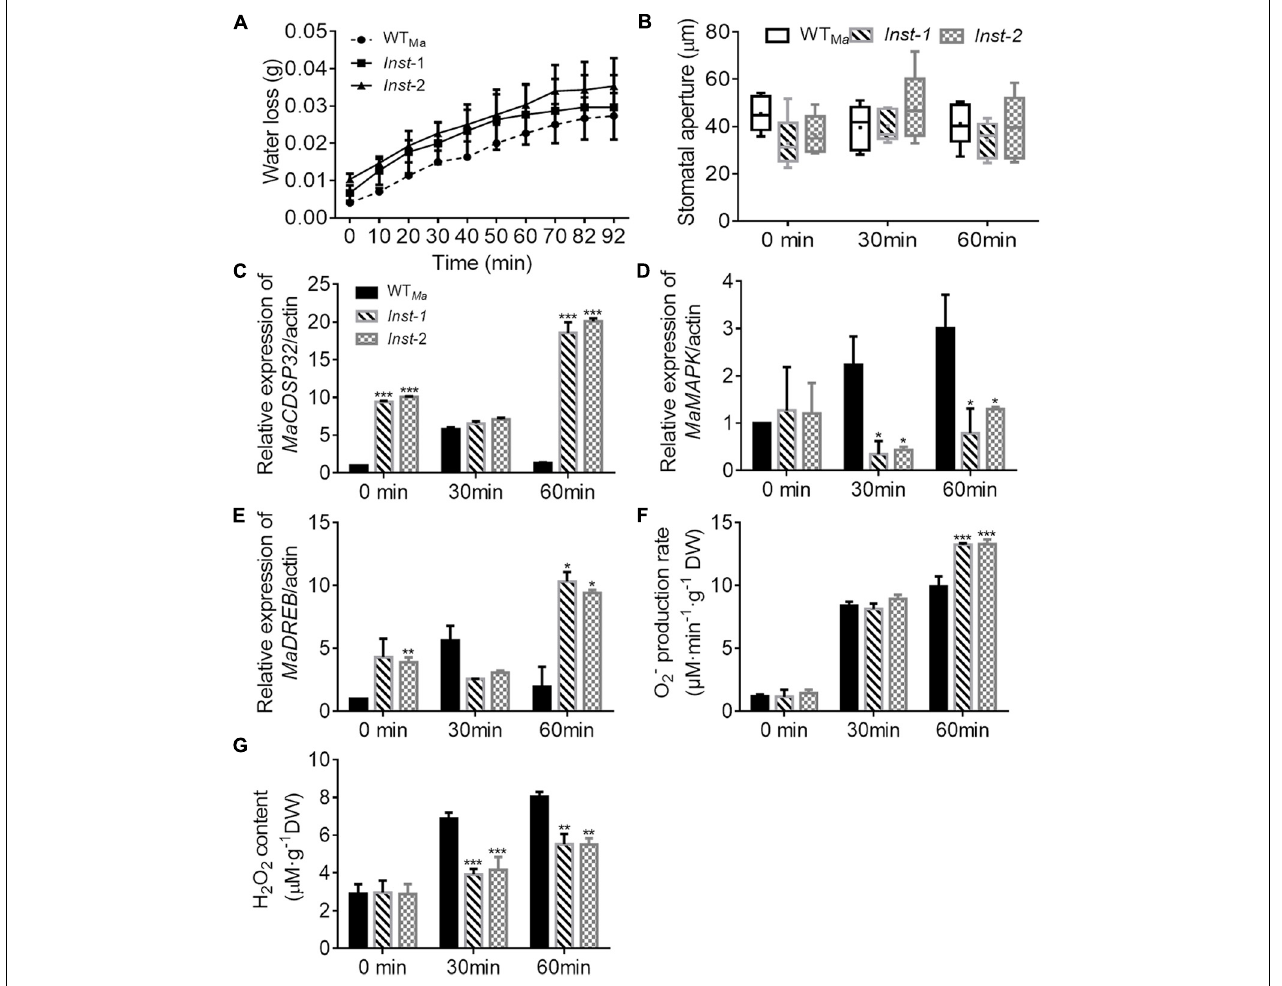
FIGURE 3 | The transient overexpression of MaCDSP32 increases leaf water loss under desiccation conditions in mulberry. (A) Water loss, (B) Stomatal aperture after 0, 30, and 60 min of desiccation. (C–E) Relative expression of MaCDSP32 (C) , MaMAPK (D) , and MaDREB1 (E) genes. (F–G) Quantification of H 2 O 2 (F) and O 2 − (G) contents. WT Ma , leaves of wild-type ShinIchinose ; Inst -1 and Inst -2, leaves of ShinIchinose transiently overexpressing MaCDSP32 . At least three biological replicates were included. Asterisks indicate significant differences between the transgenic and wild-type leaves ( t -test, * P < 0.05, ** P < 0.01, *** P <